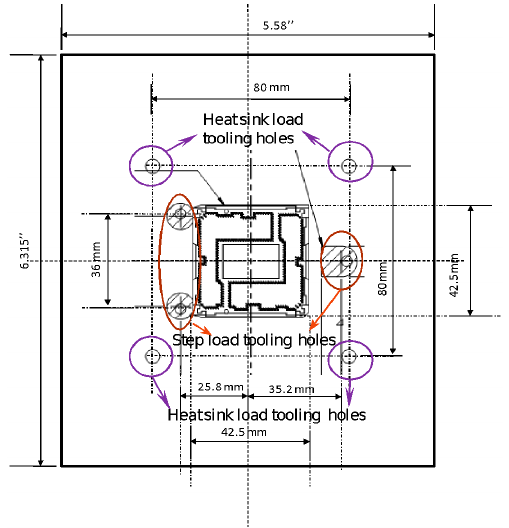
Figure 1. Schematic representation.